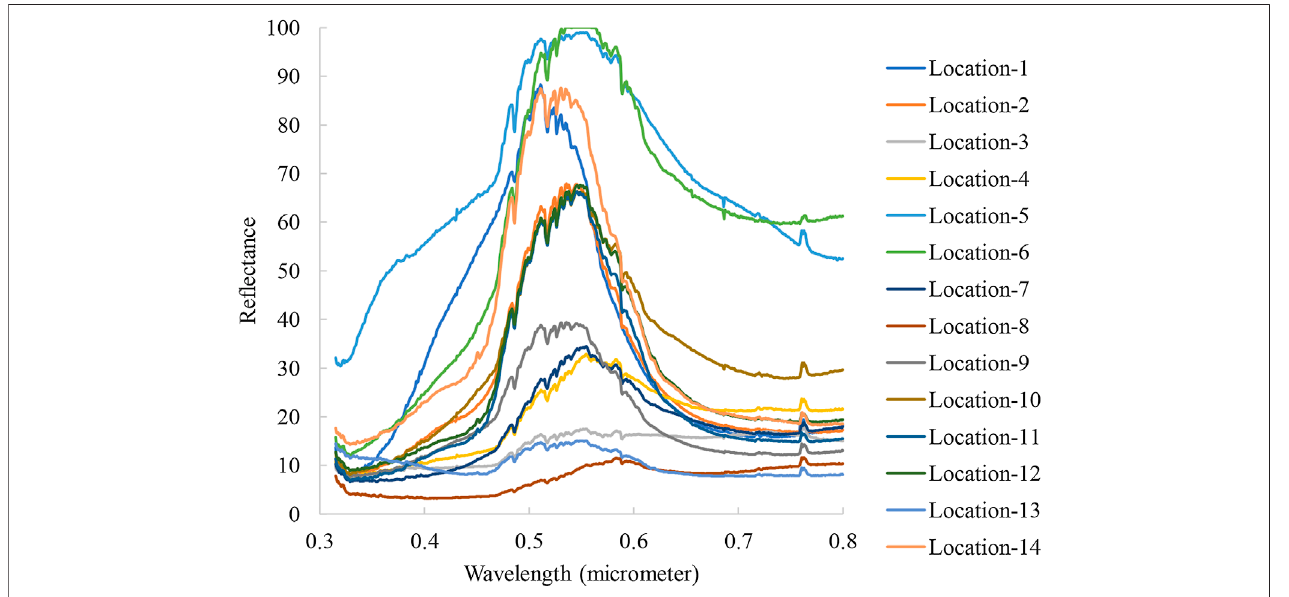
FIGURE 10 | Re fl ectance spectra of the collected samples.